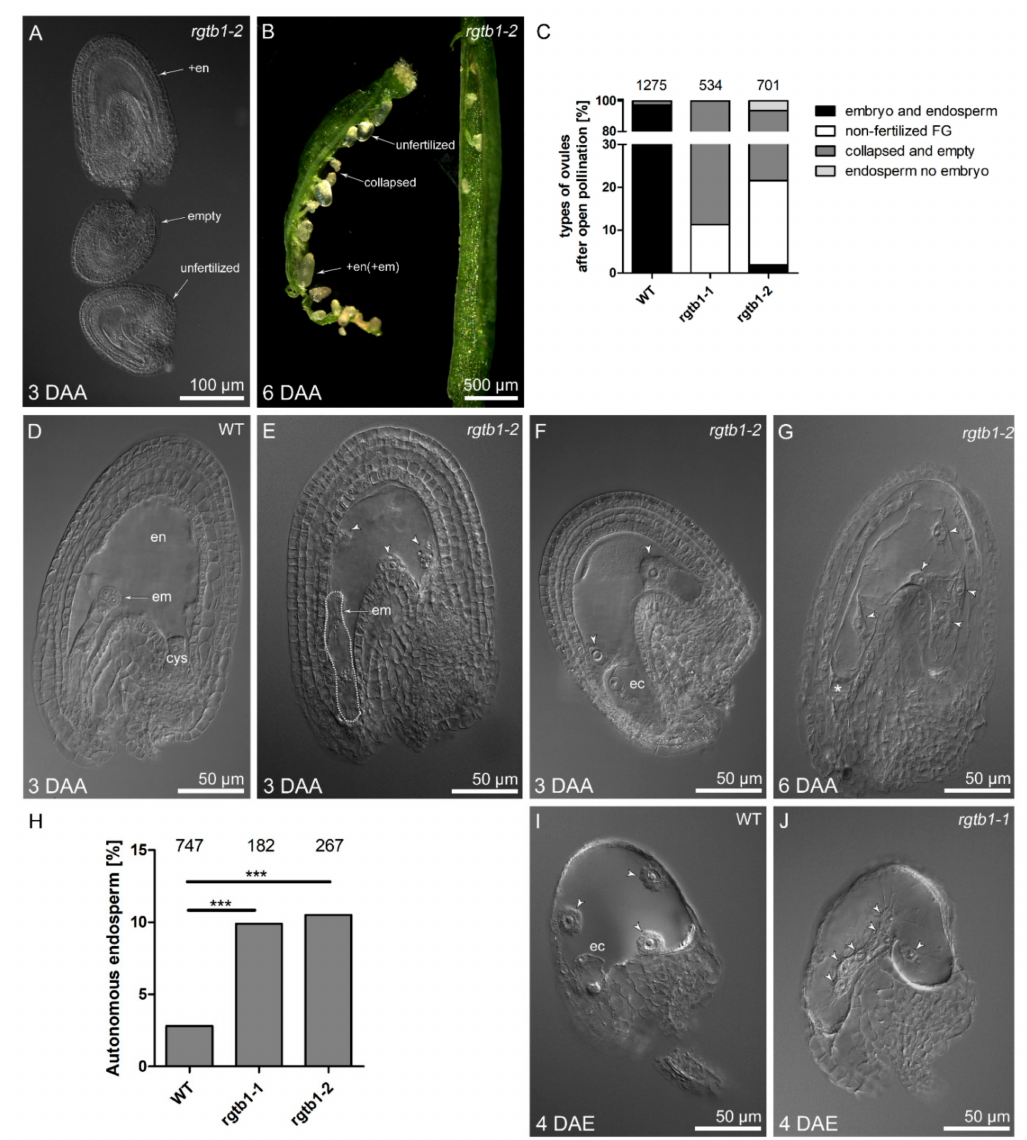
Figure 3. Post-anthesis stages in rgtb1 . Types of ovules after pollination ( A – G ) or emasculation ( H – J ). ( A , B ) Several types of neighboring ovules were noted in the same silique of rgtb1 mutant after self-crossing. White arrows point to shrunken unfertilized empty ovules (not containing FG), mature unfertilized ovules and enlarged ovules after endosperm (and embryo) initiation. ( A ) Cleared ovules observed in DIC contrast, scale bar 100 µ m; ( B ) representative example of one fresh silique dissected in two parts observed under a stereomicroscope, scale bar 500 µ m. ( C ) quantification of the types of ovules found in WT vs. rgtb1 mutants after self-pollination: ovule with embryo and endosperm that were dominating in WT ( D ), but noticed very rarely in rgtb1 ( E ) and seed-like structures with enlarged central cell or endosperm found only in rgtb1 ( F , G ). Scale bar 50 µ m for images ( D – G ). The fraction of ovule types after open pollination in WT and rgtb1 mutants was counted in cleared preparations under a microscope 6 days after open pollination (6DAP). The number of ovules counted for each genotype is given above the bars. ( H – J ) Ovules in WT and rgtb1 after emasculation form autonomous endosperm. ( H ) Quantification of ovules forming autonomous endosperm (AE) in WT and rgtb1 mutants. AE formation was counted in cleared preparations or in freshly isolated ovules under a microscope 4 days after emasculation (4DAE). The total number of ovules counted for each genotype is given above each bar. Values were compared with a z-test for two proportions; *** denotes a p value < 0.001. ( I , J ) Examples of AE in both WT ( I ) and rgtb1 ( J ) emasculated flowers. AE have several nuclei ( I , J , arrowheads). Scale bar 50 µ m for images ( I , J ). Abbreviations: ec—egg cell; cys—chalazal cyst,